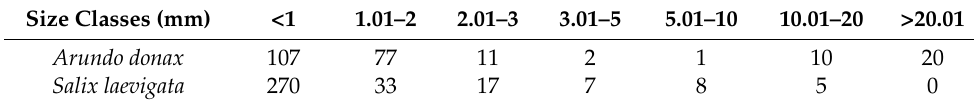
Table 5. Summary of number of roots by size class input into the RipRoot